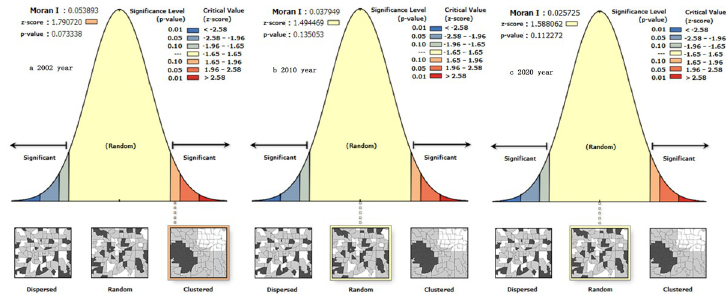
Fig 2. Global autocorrelation index changes of GDP in Russian Federation from 2002 to 2020.